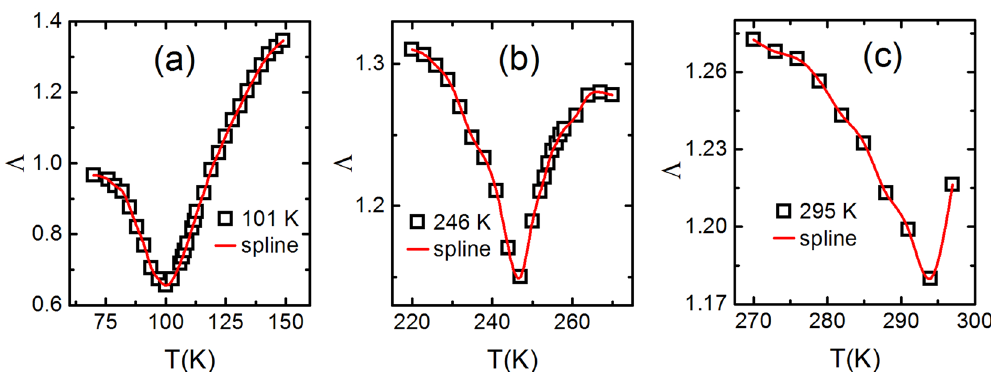
Figure 10. ( a ) The square symbol represents the M S versus T plot and the solid curve is its fitting with Eq. (5) which results into β = 0.253. The triangular symbols corresponds to the χ − fitting with Eq. (6) which yields γ = 1.23. ( b ) The square symbol is representing the M S /( dM S / dT ) versus T plot and the solid curve is its fitting with Eq. (10) which results into β = 0.258. The triangular symbol represents the χ − 1